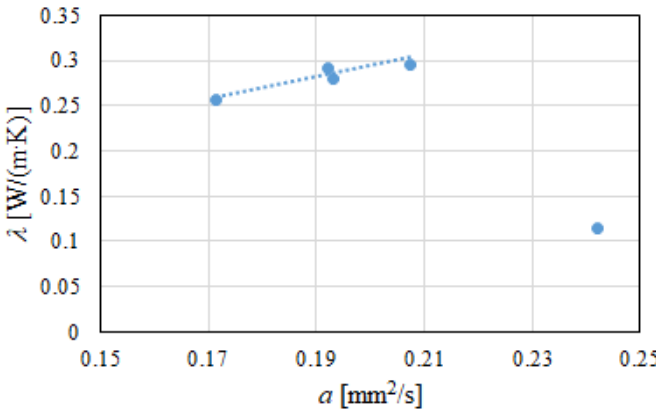
Figure 6. Graph of the dependence λ = f(a) for modified gypsum and geopolymer samples. The geopolymer (GF) sample showed the highest thermal diffusivity value, equal to 0.2421 mm 2 /s. In turn, among the tested gypsums, the highest values of a were